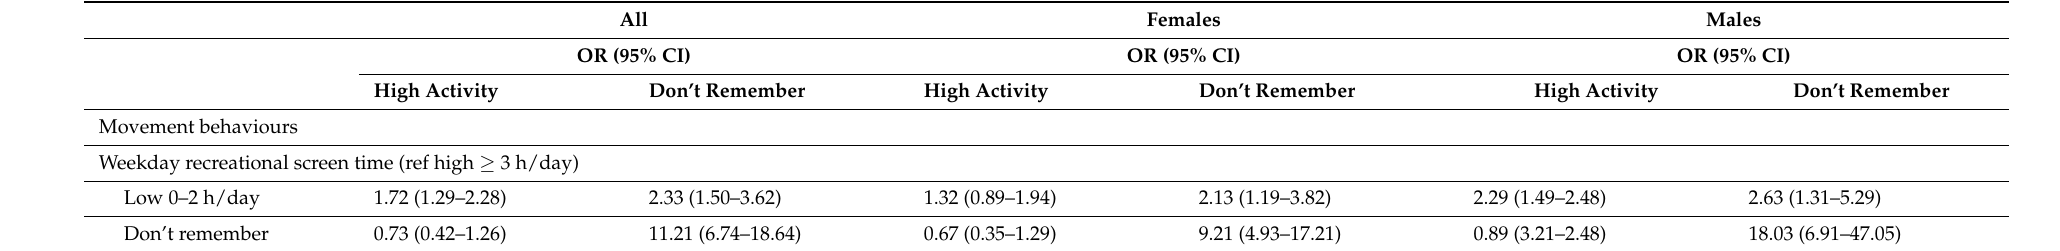
Table 3. Adjusted odds ratios (OR), and their 95% confidence intervals (95% CI) of NextGen participants achieving high physical activity (reference: low